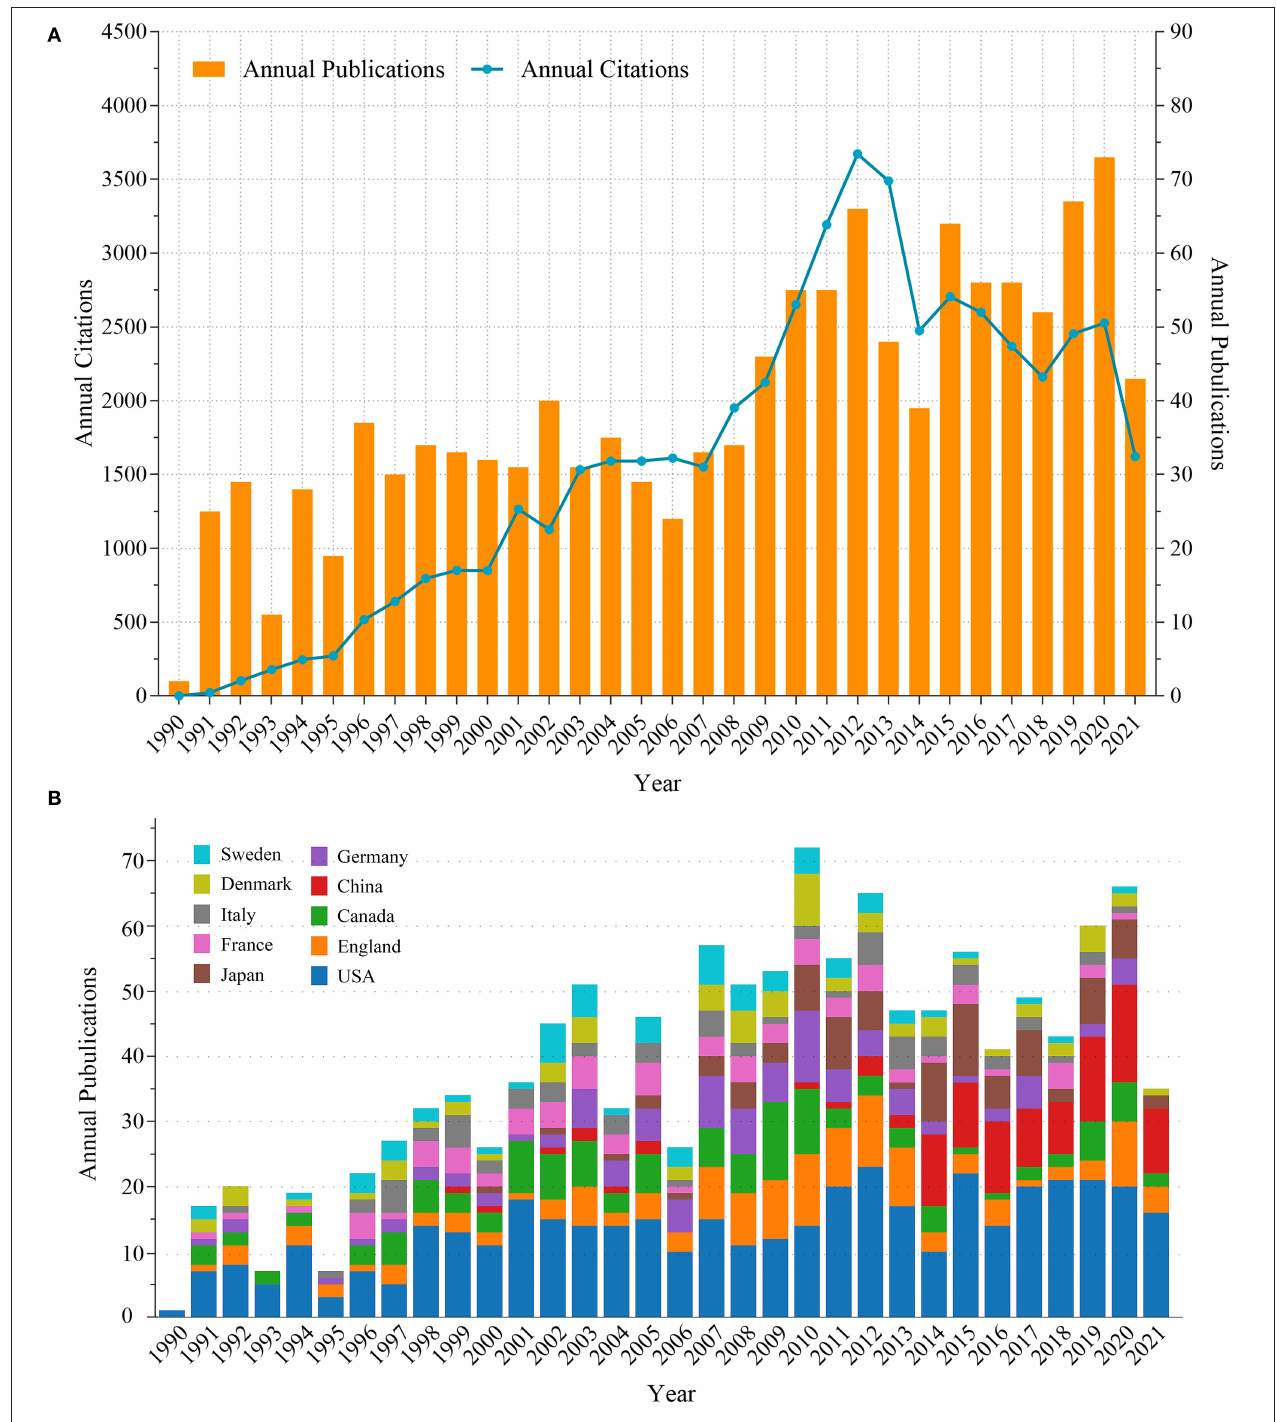
FIGURE 2 | Trends in annual citations and publications (A) and trends in annual article counts in top 10 productive countries (B) on VTE after hip or knee arthroplasty.